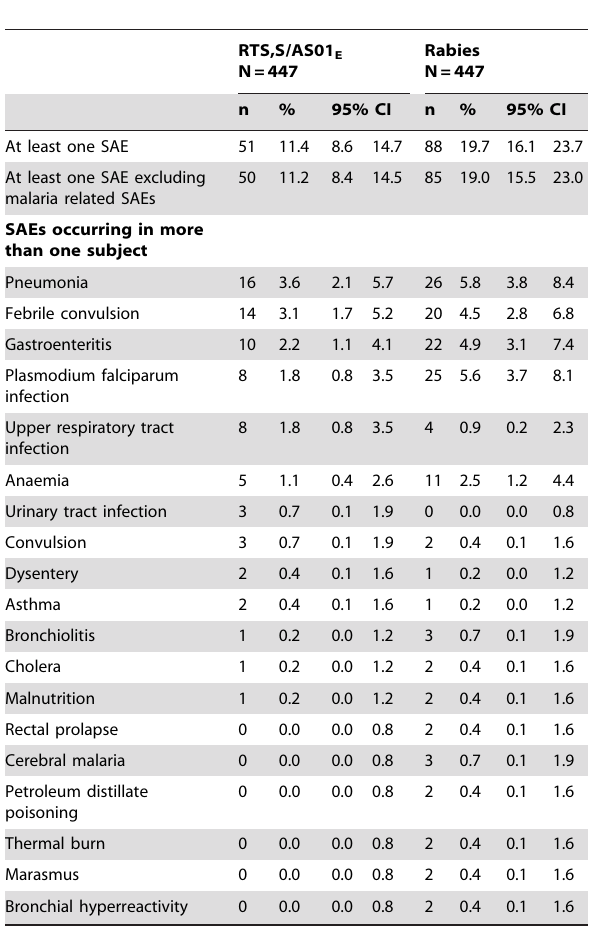
Table 5. Serious Adverse Events (The number of severe malaria cases have been previously been described [19]. One child in the RTS,S/AS01 E and 9 children in the rabies vaccine arm were diagnosed with severe malaria.)